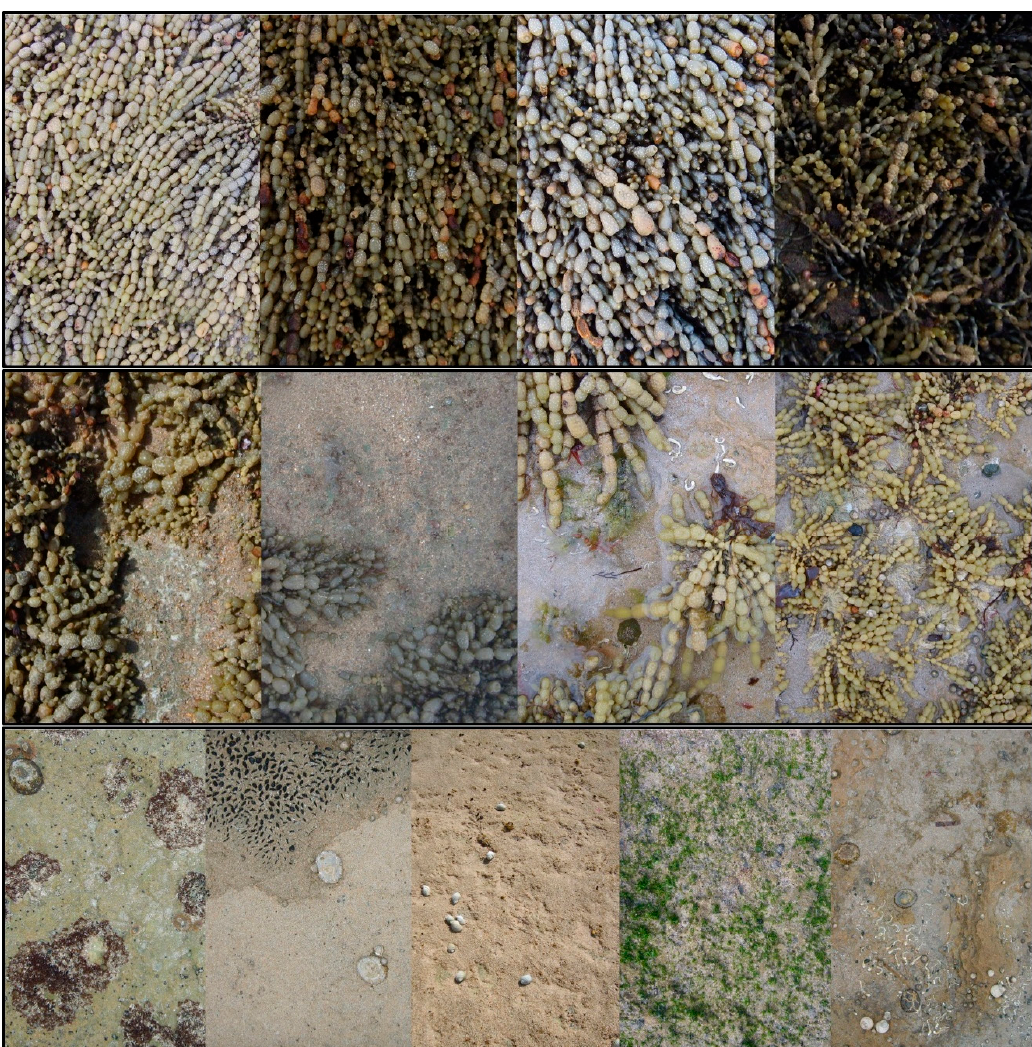
Figure A1. Photo pane showing dense (top), patchy (middle) and absent/negligible (bottom) areas occurring on rocky seashores in Victoria and as sampled. The scale of each image is approximately 20 cm across.